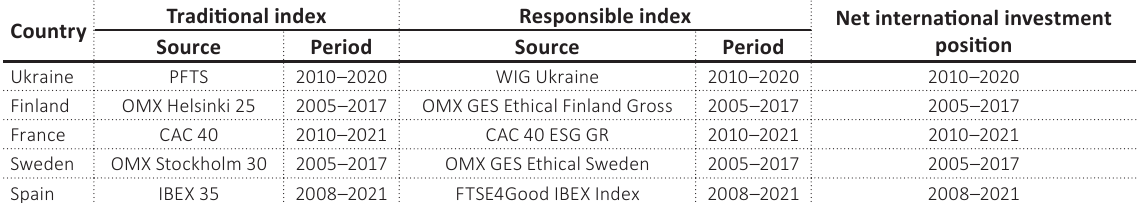
Table 3. Analyzed data sources and their periods